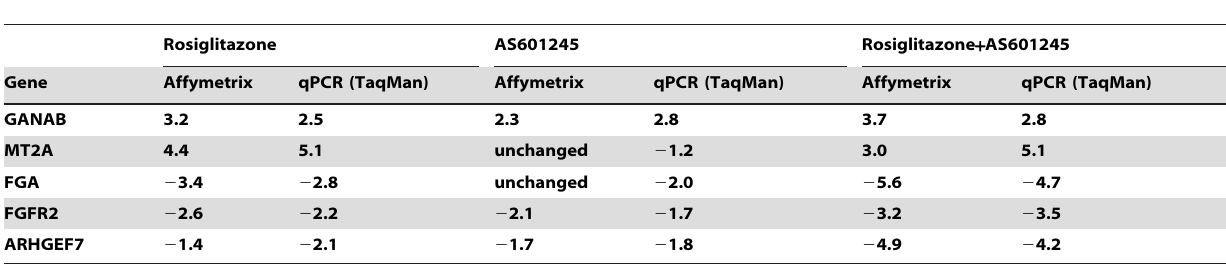
Table 6. Gene expression detected by affymetrix and quantitative Real-Time PCR.